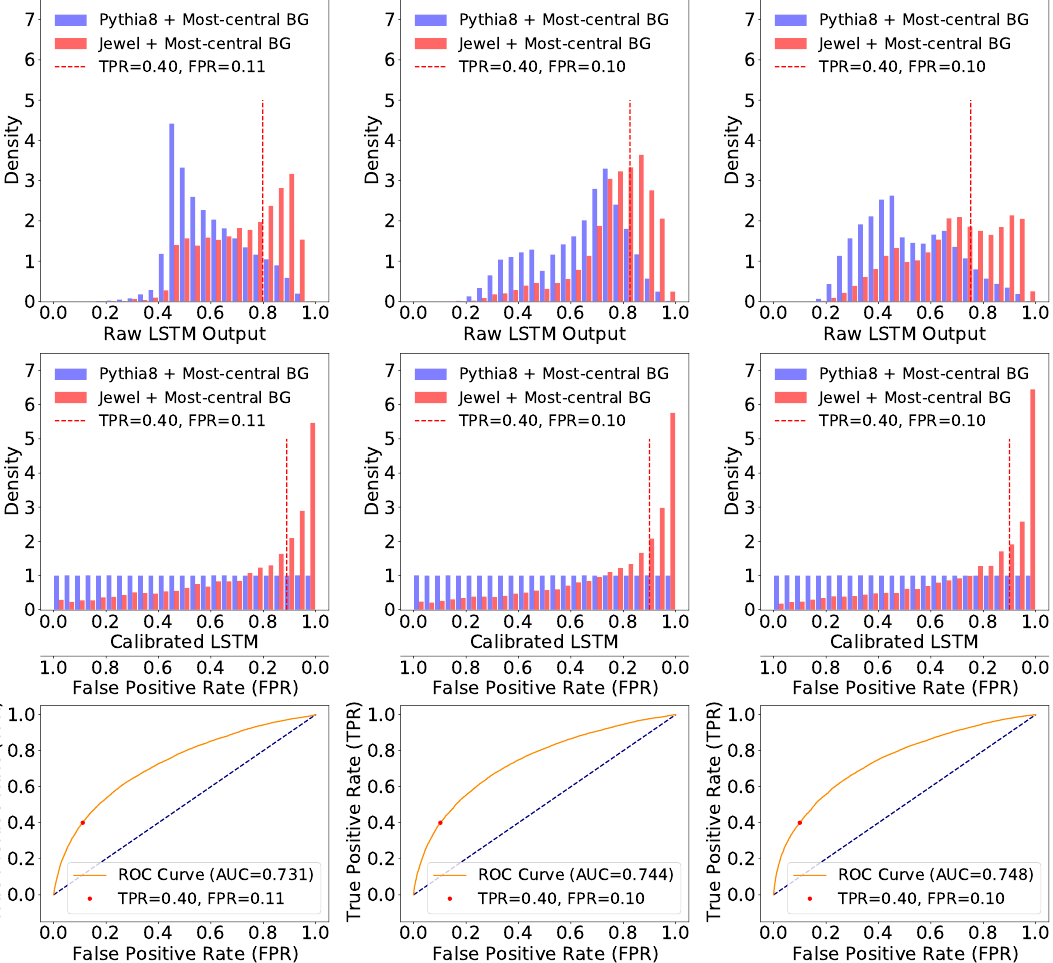
Figure 9 . Distributions of the raw LSTM output from top three best-trained neural networks (top panels). Distribution of calibrated LSTM output (middle panels), and the corresponding ROC curve (bottom panels). The red lines/points corresponds to thresholds determined with